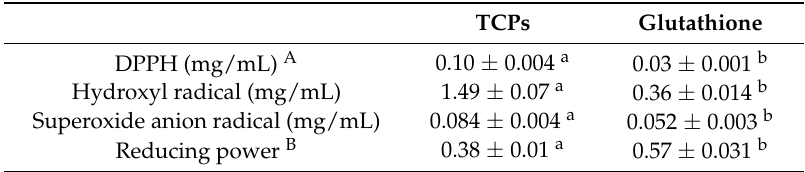
Table 2. Antioxidant activities of